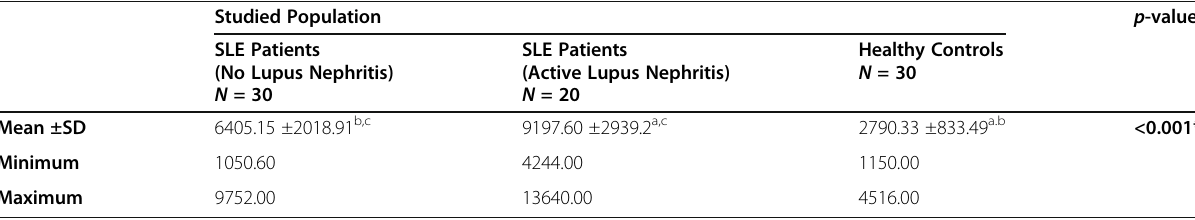
Table 1 DKK1 serum level among studied population Studied